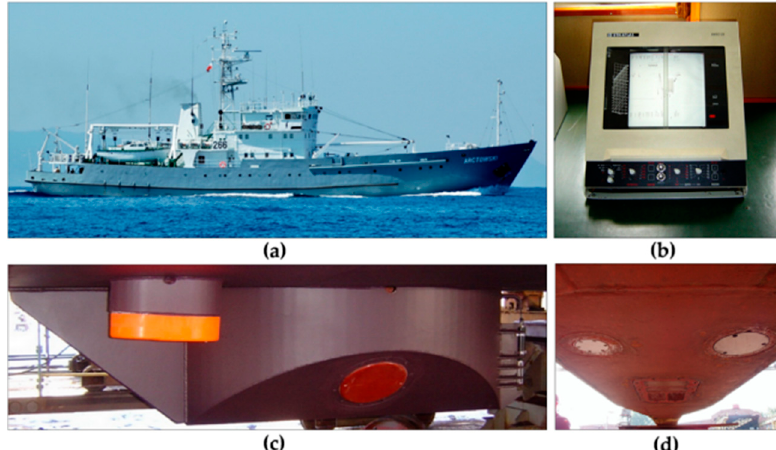
Figure 4. Survey platform with bathymetric measuring systems: ( a ) the Arctowski hydrographic ship;